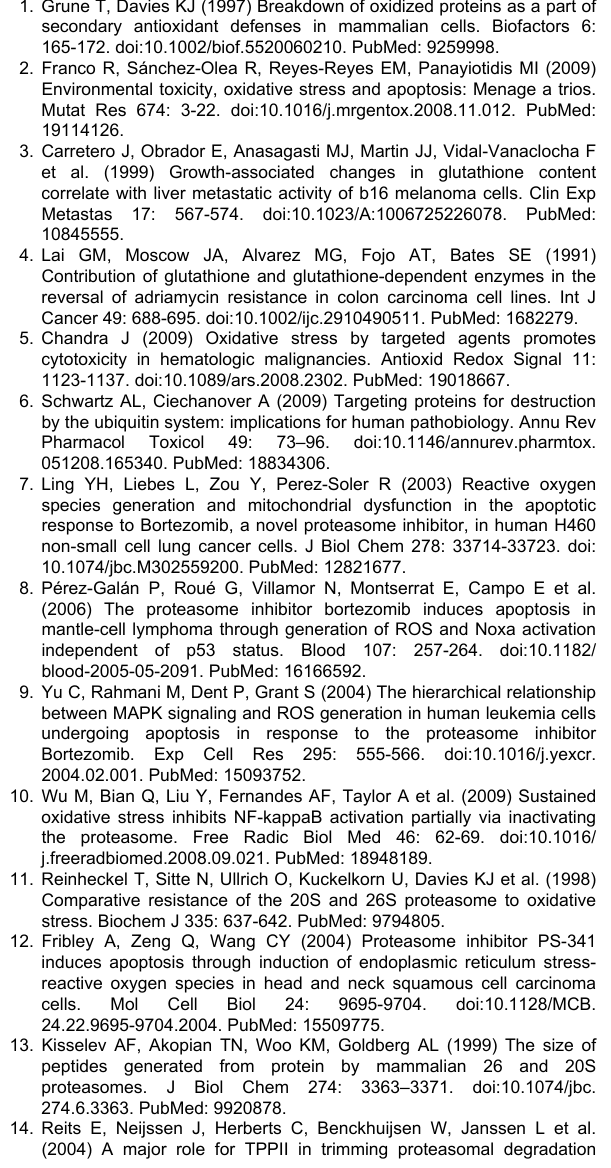
Figure S1. cultures exposed to octanoic acid (200 µM, black bars) or to controls, respectively. Data are expressed as means ±SD values of triplicate data from three independent experiments,